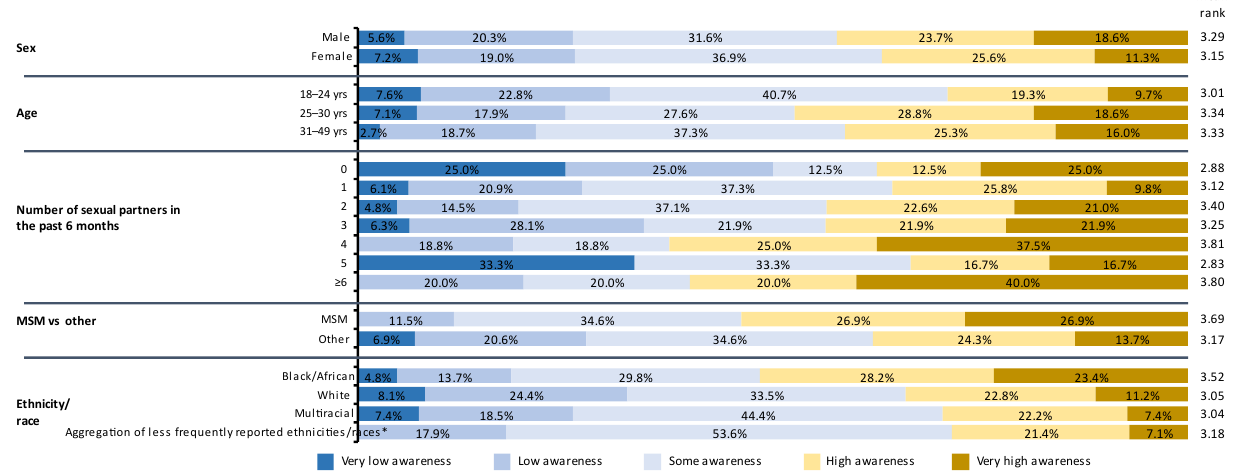
Figure 4. Self-declared knowledge about gonorrhea according to sex, age, number of sexual partners in the previous 6 months, MSM versus other, and ethnicity/race; ( N = 450). Age and ethnicity/race were significantly associated with gonorrhea knowledge (Kruskal–Wallis p = 0.001 and p = 0.002, respectively). Very low awareness = I think I have heard of gonorrhea, but I’m not sure what it is; low awareness = I have definitely heard of gonorrhea, but I’m not sure what it is; some awareness = I have heard of gonorrhea, and I think I know a little about it; quite high awareness = I have heard of gonorrhea, and I think I know a reasonable amount about it; very high awareness = I have heard of gonorrhea, and I think I know a lot about it. MSM, men who have sex with men. * Less frequently reported ethnicities/races = American Indian, Alaskan Native, Asian, Native Hawaiian, Pacific Is- lander, Hispanic, Latino, and other ethnicities/races.